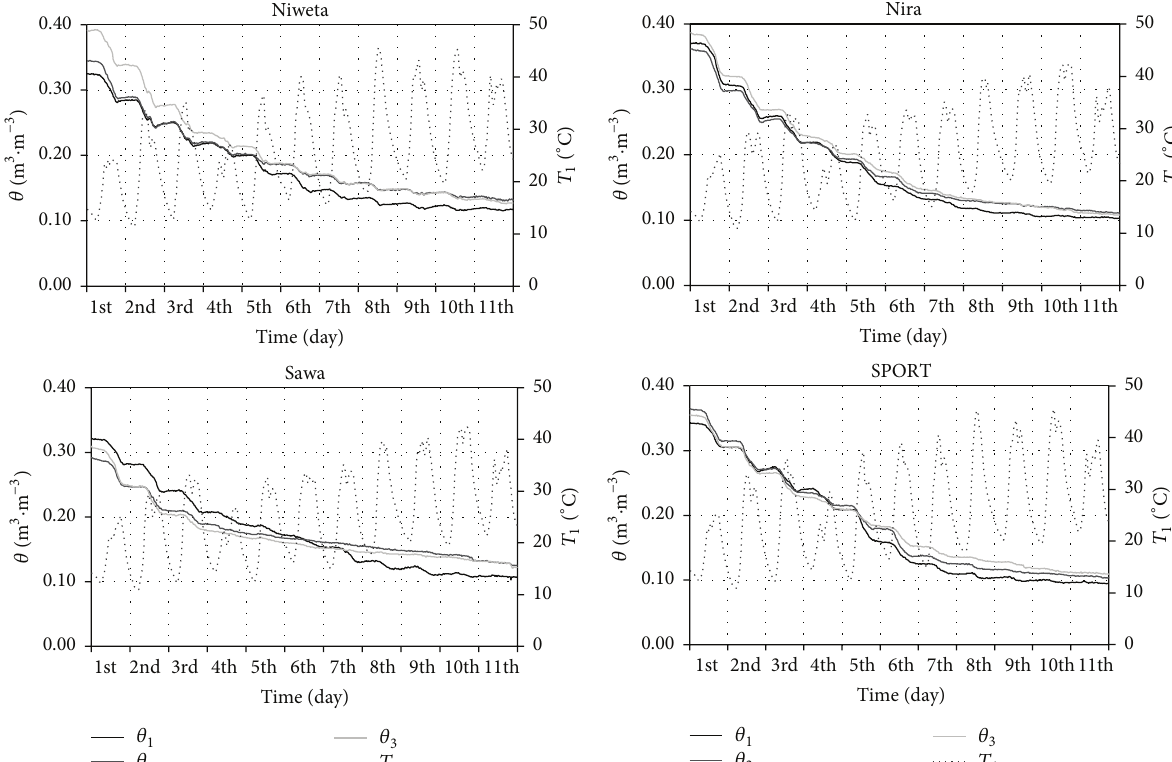
Figure 3: Dynamics of moisture in the period of 11–21.06.2013 for 4 grasses; 𝜃 𝑗 is volumetric moisture in 𝑗 th layer and 𝑇 1 is temperature at the depth of 2.5